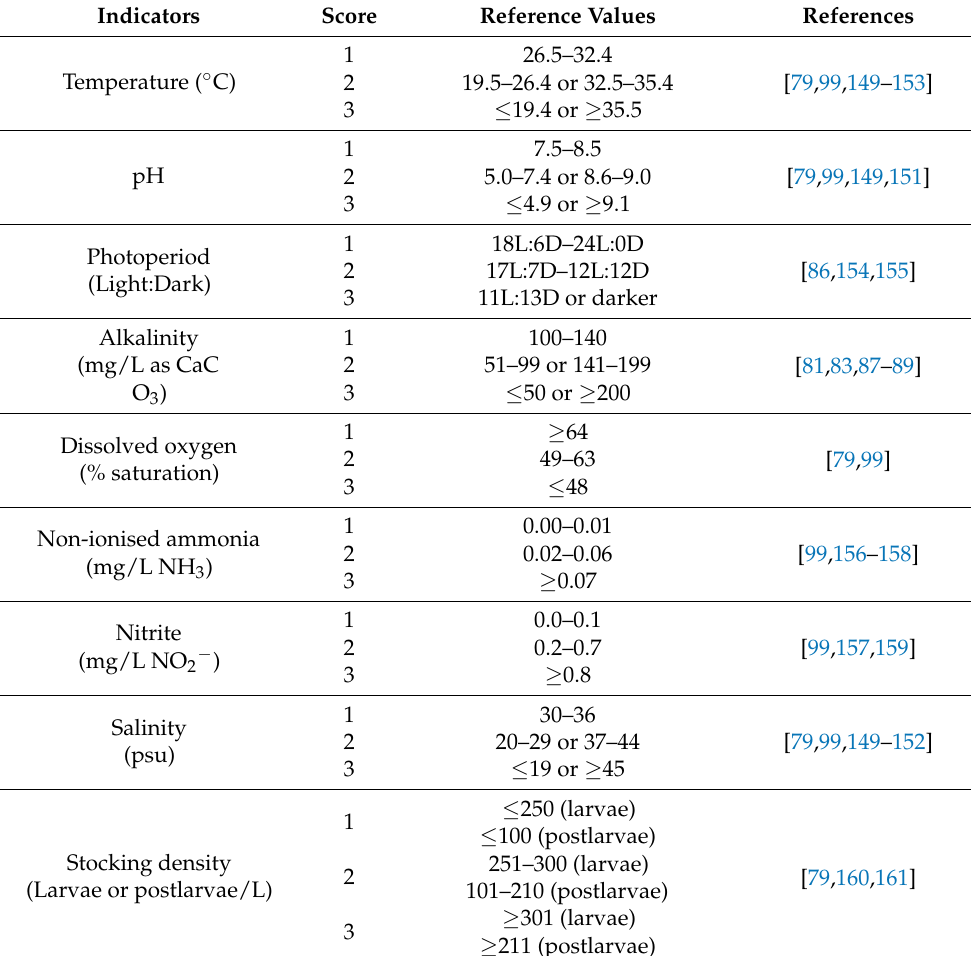
Table 6. Environmental indicators for larvae and postlarvae of Penaeus vannamei .